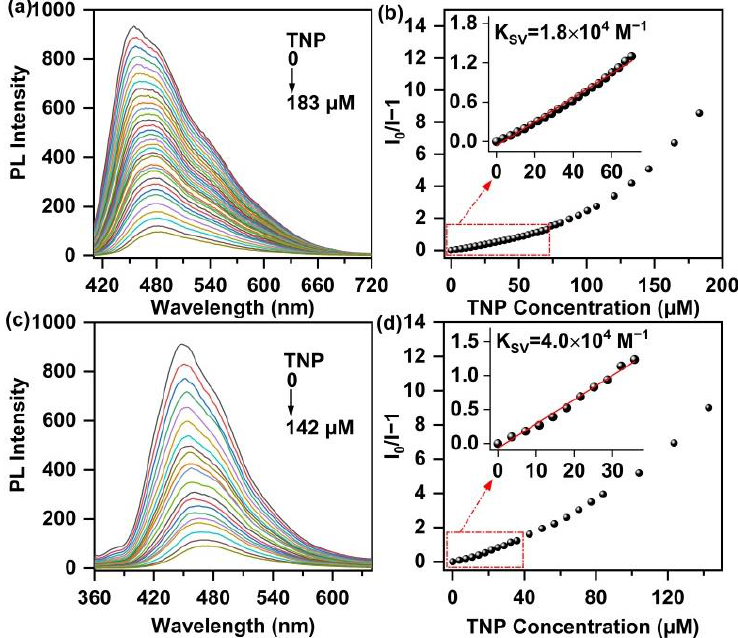
Figure 5. Emission spectra of l -PAnTPE ( a ) and PAnTPE ( c ) aqueous dispersion with increasing amounts of TNP. S–V plots of PL intensity (I 0 /I − 1) of l -PAnTPE ( b ) and PAnTPE ( d ) vs. TNP concentration. Table 1. Literature data of polymer materials for TNP detection.